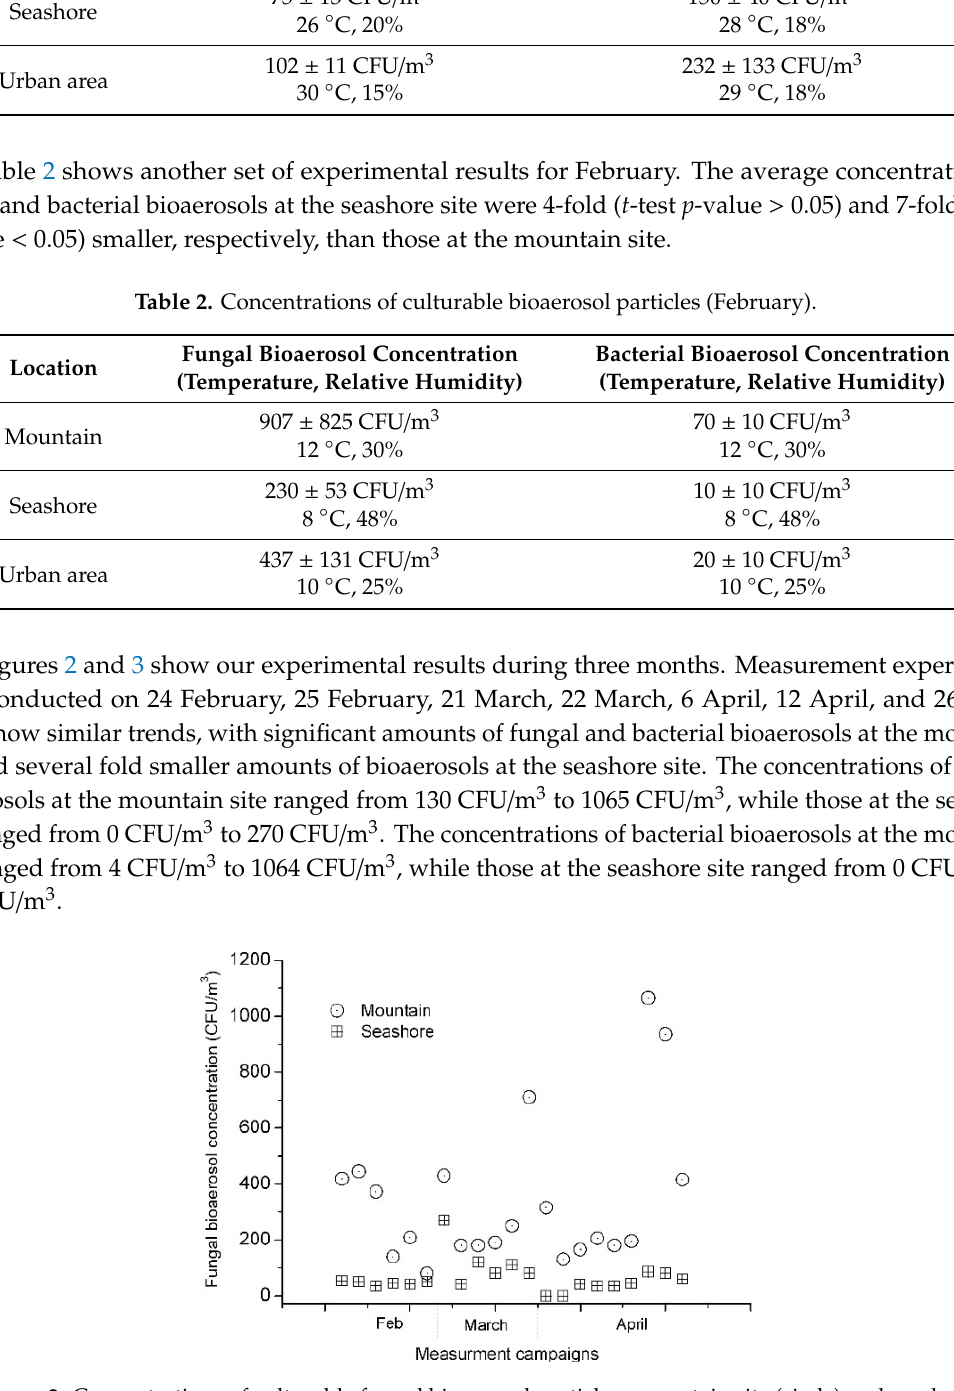
Figure 2. Concentrations of culturable fungal bioaerosol particles: mountain site (circle) and seashore site (square).